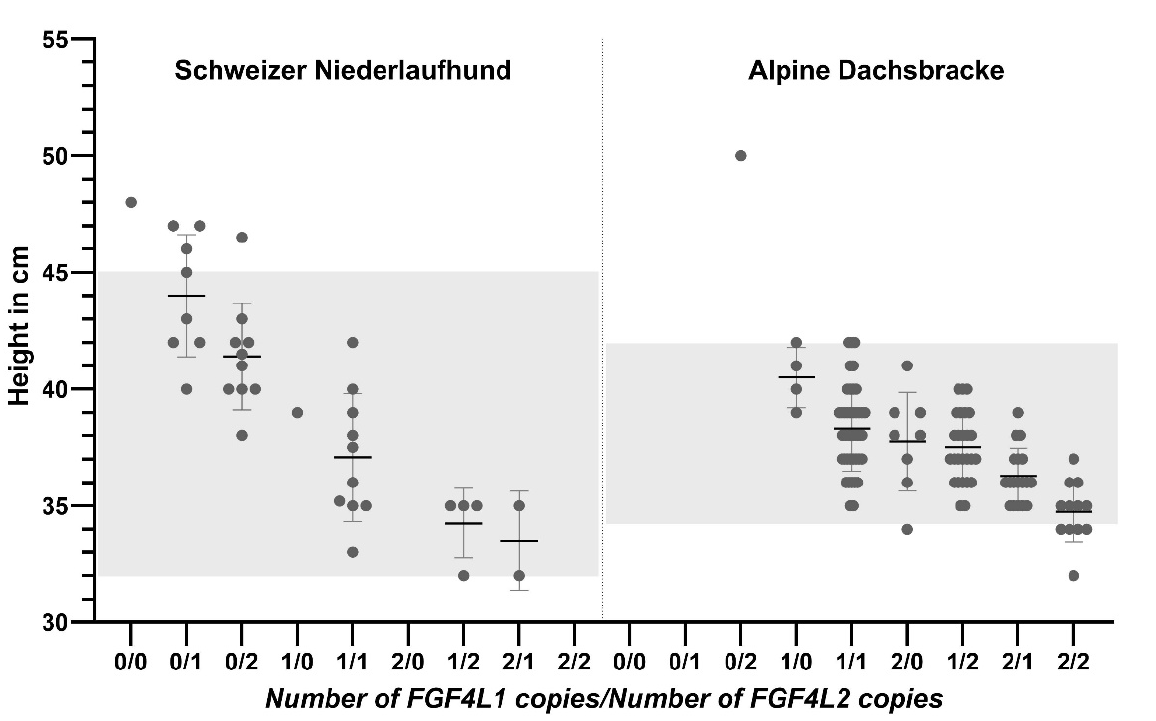
Figure 2. Sex had a significant effect on manus length ( p = 0.005), scapular length ( p = 0.04), and head width ( p = 0.003).